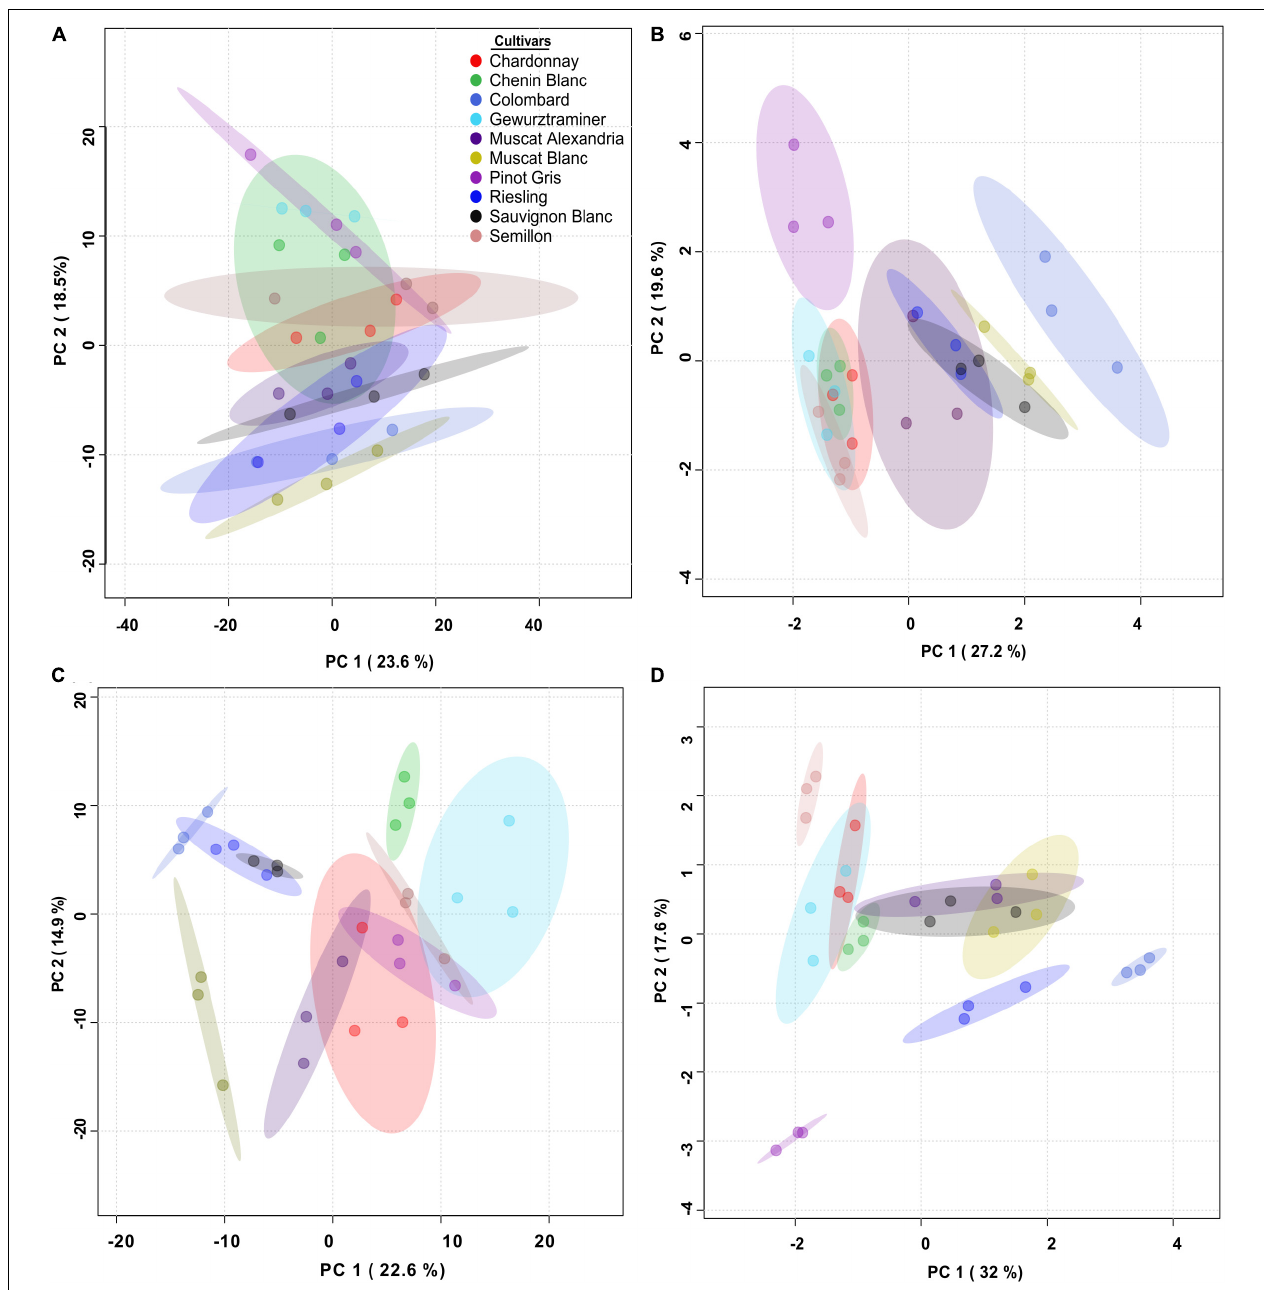
FIGURE 3 | Overview of the differences between cultivars in skin phenylpropanoids at véraison (left) and harvest (right) grown at the Mitzpe Ramon (A,B) and Ramat Negev (C,D) vineyards during 2017–2019. Principal component analyses (PCAs) were plotted using mean values of four biological replicates ( n = 4) in each season. PCAs for véraison samples were generated using pareto-scaled data. PCAs for harvest samples were plotted using log-transformed and pareto-scaled data. Samples are colored by cultivar